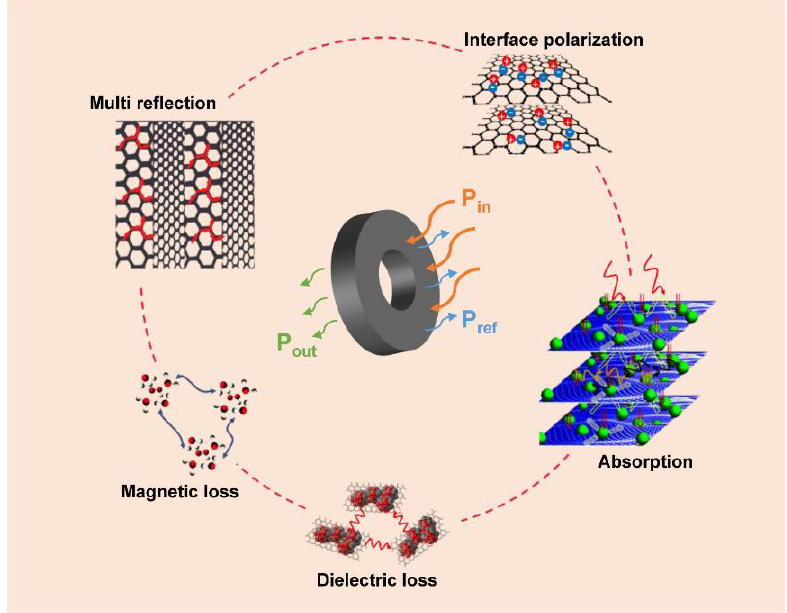
Figure 7. The EWA mechanisms of the PU/WTR@CNT/Fe 3 O 4 composite foam.